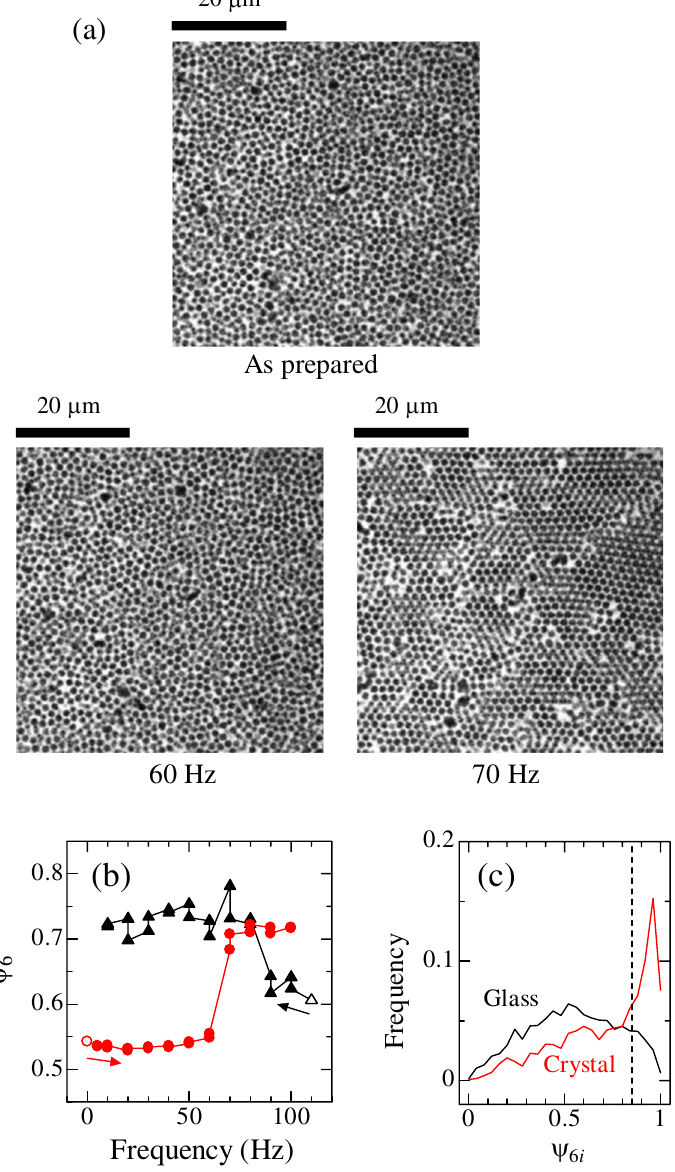
Figure 1. ( a ) Representative images taken before and after applying horizontal oscillations at 60 and 70 Hz. ( b ) Evolution of the averaged value of ψ 6 i . Oscillation frequency was varied from 5 to 100 Hz (circles) and from 100 to 10 Hz (triangles). Open symbols denote results of as-prepared samples. ( c ) Histograms of ψ 6 i for an as- prepared sample (glass state) and for the corresponding sample after oscillation was applied from 5 to 100 Hz (crystalline state). The dashed line indicates ψ 6 i =